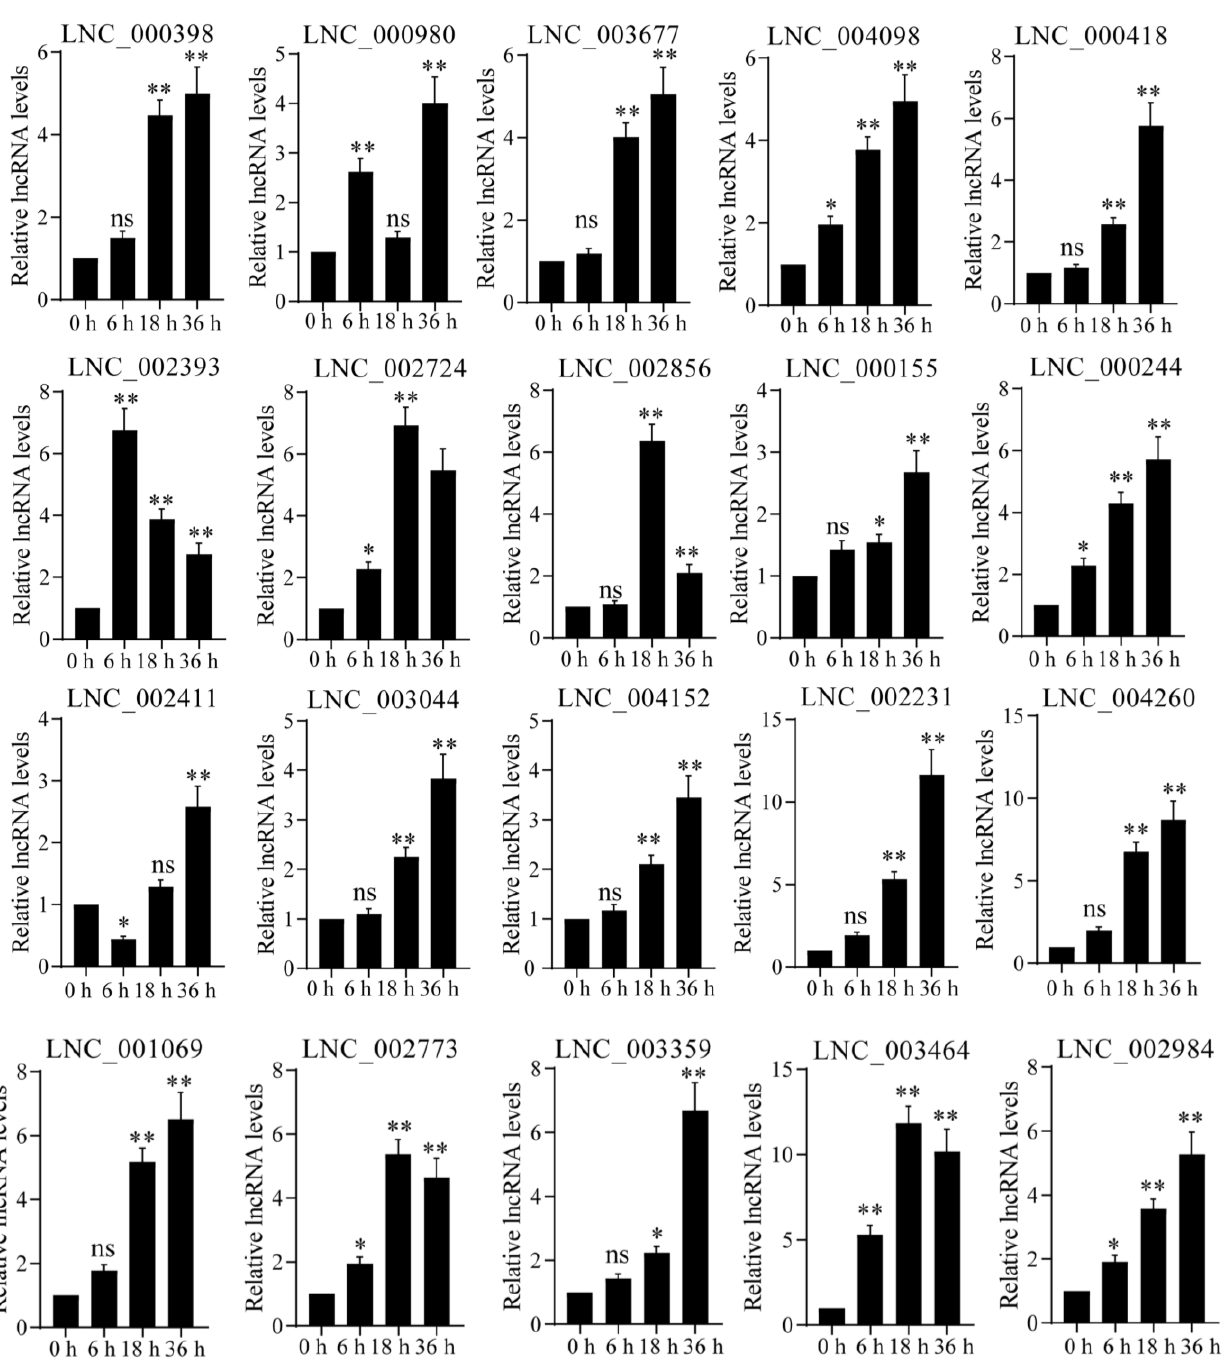
Figure 6. Key DELs of the flavonoid synthesis pathway were up-regulated after UV-B treatment. The gene expression levels were analyzed by quantitative RT-PCR analysis; the Y -axis indicates the relative expression level; the X -axis indicates UV-B treatment time (h); The data were calculated from three biological replicates. Vertical bars are the means ± SEM. Significant difference (ns p > 0.05, * p < 0.05, ** p < 0.01). The target genes of these DELs were chalcone synthase